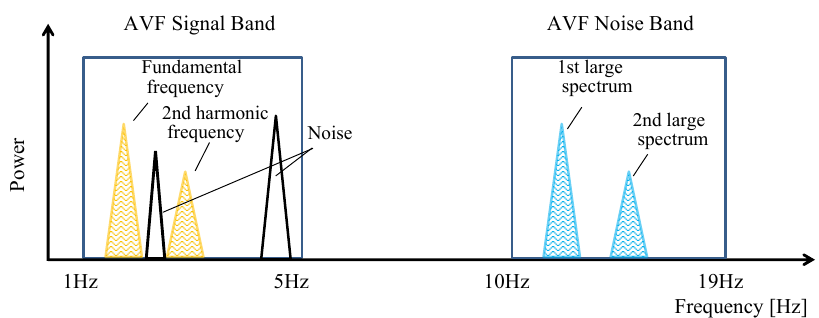
Figure 6. Frequency spectrum of AVF pulse wave